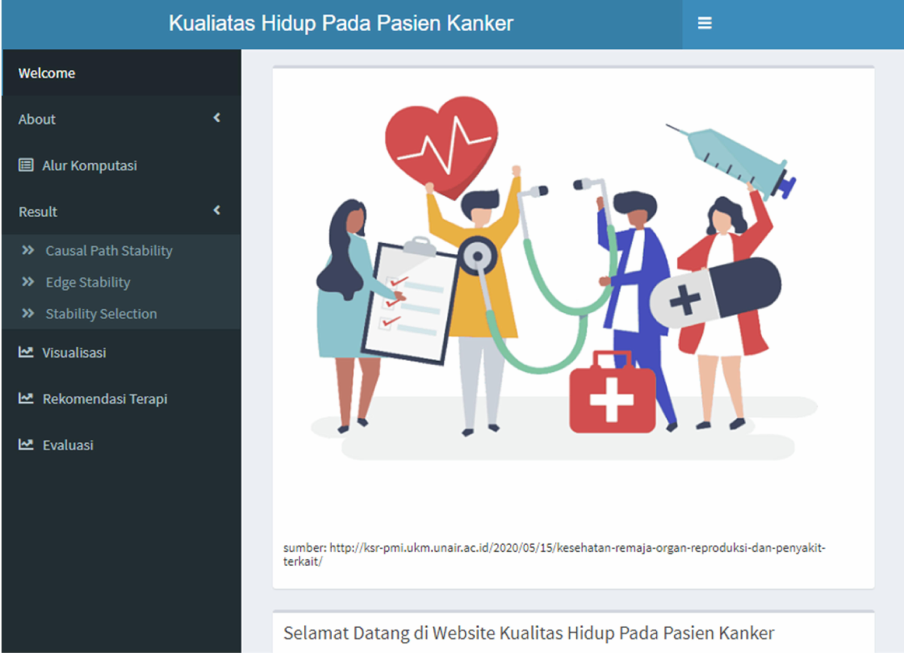
Fig. 6. Shiny website displaying the quality of